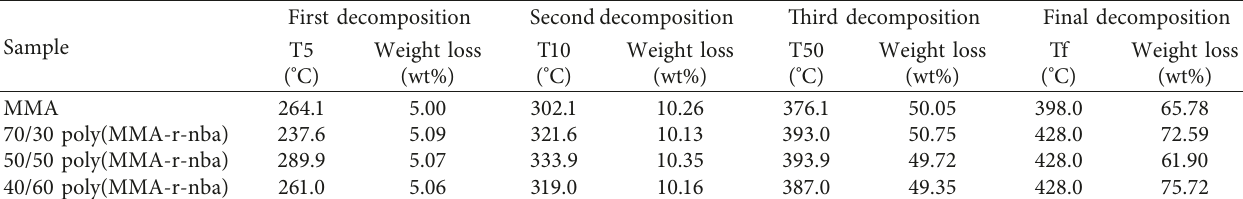
Table 3: Polymer decomposition results with